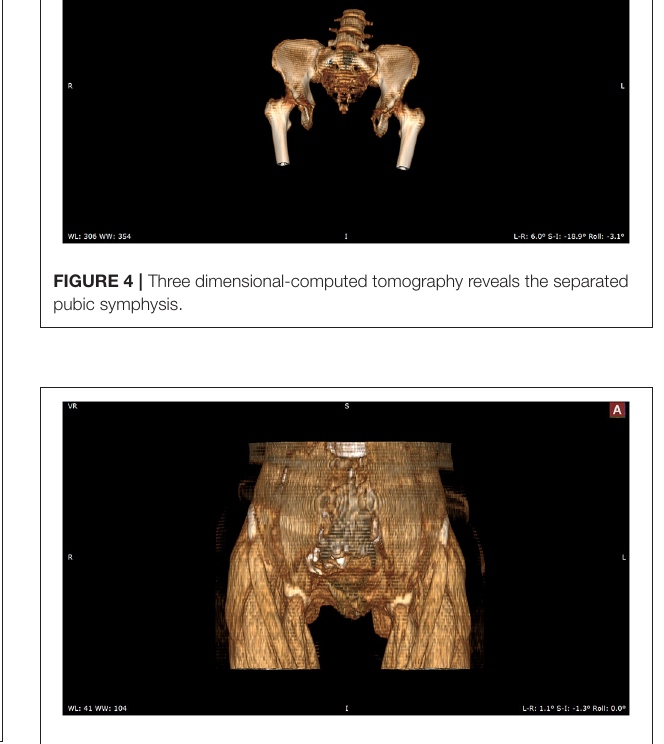
FIGURE 5 | Three dimensional-computed tomography reveals the separated rectus